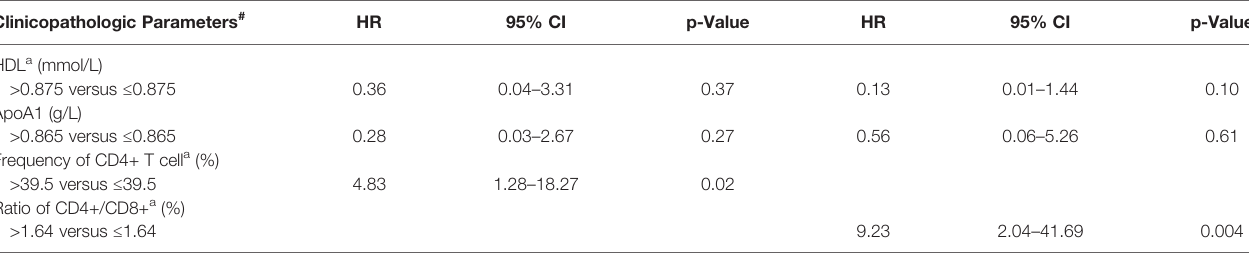
HR, hazard ratio; HDL, high-density lipoprotein; ApoA1, apolipoprotein A1. # Since frequency of CD4+ T cell was strongly correlated with ratio of CD4+/CD8+ with rho value of 0.73 (p < 0.001), these two parameters were separately included in the Cox model. a Optimal cutoff points were estimated by receiver operating characteristic (ROC) curve